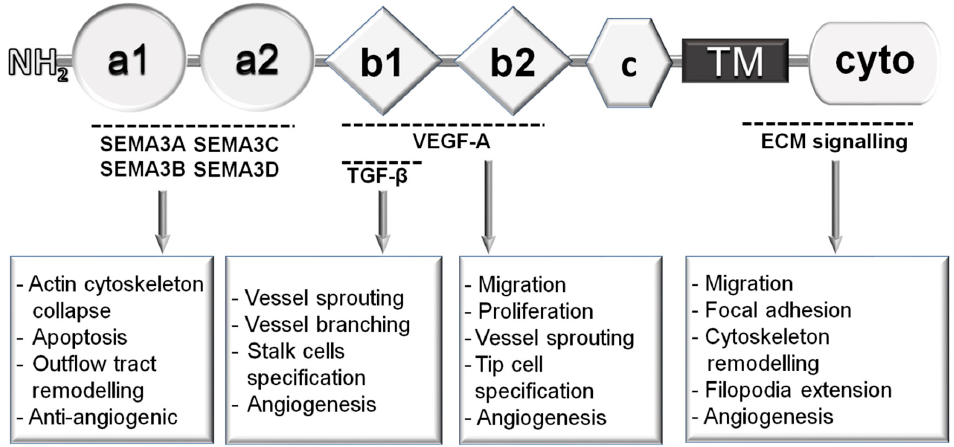
Figure 1. Representation of the transmembrane protein Neuropilin-1 (NRP1): NRP1 consists of seven domains, two complement (CUB) domains (a1 and a2), two coagulation factor (FV/FVIII) domains (b1 and b2), a MAM domain with homology to the meprin/antigen 5/receptor tyrosine phosphatase μ domain (c), a transmembrane domain (TM) and a cytoplasmic domain (cyto) that interacts with intracellular proteins. The boxes indicate the signalling pathways promoted by the binding of endothelial NRP1 to the indicated ligands.